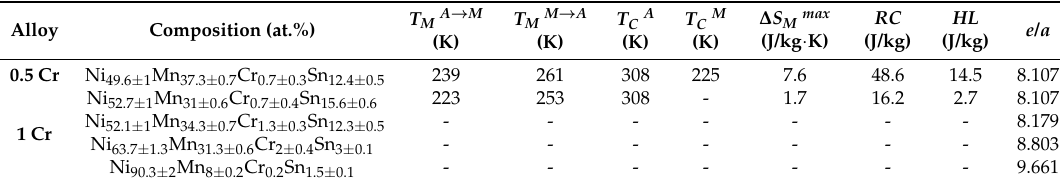
Table 1. Composition and the valence electron-to-atom ratio ( e/a ), the forward ( T M A → M ) and reverse ( T M M → A ) martensitic phase transformation (MPT) temperatures, the Curie temperature of austenite ( T C A ), the magnetic entropy change ( ∆ S M max ) and refrigerant capacity ( RC ) determined under the magnetic field change of 1.5 T for 0.5 Cr and 1 Cr alloys.